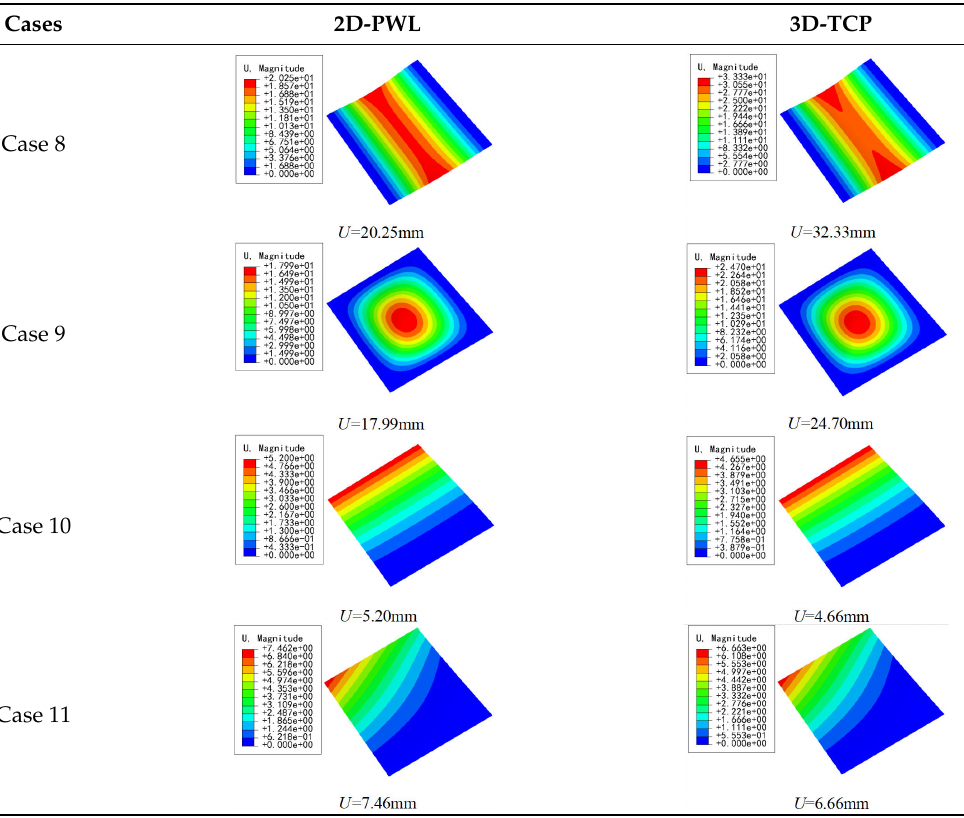
Table 15. Comparison of bending displacement between 3D-TCP and 2D-PWL under different